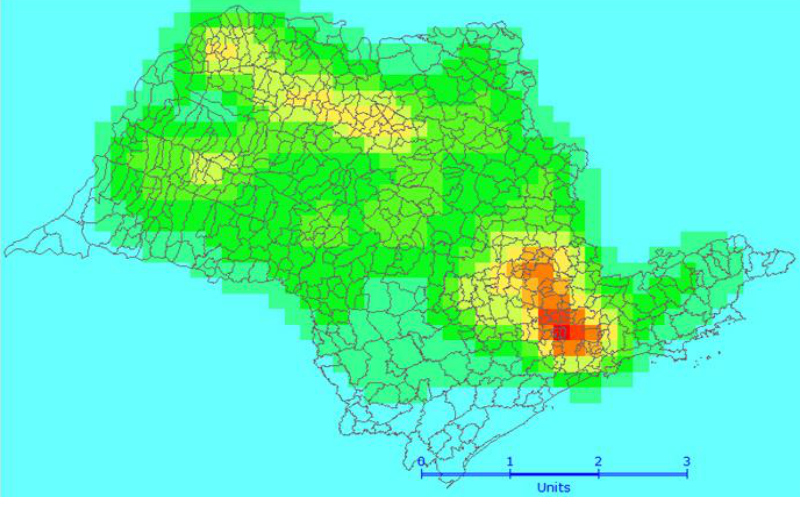
Figure 4. Critical areas (hot spots) for air pollution in Sao Paulo: all sources of air pollution—mobile, stationary and biomass